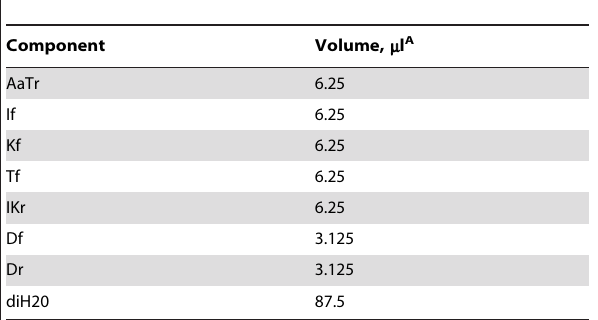
Table 8. Preparation of 125 m l primer stock for V. dahliae–V.